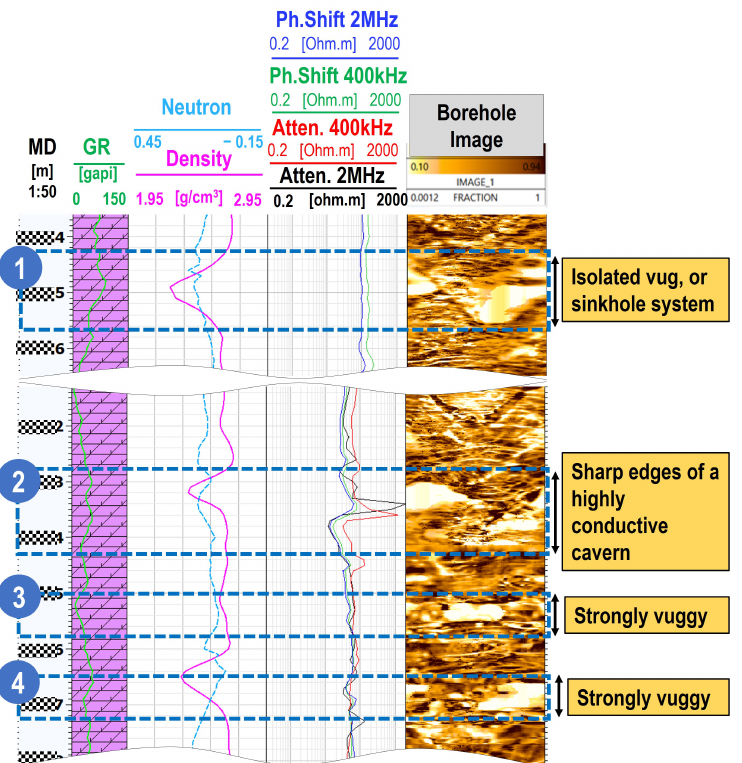
Figure 10. Example of resistivity measurements in vug and cave intervals. Courtesy of Lundin